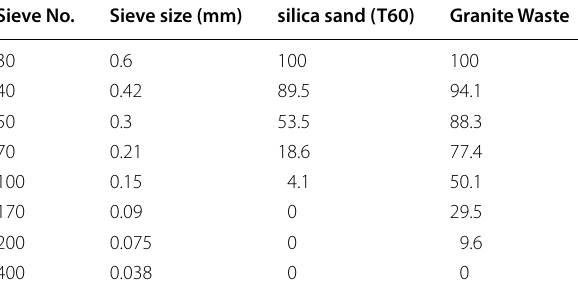
Table 2 Grading of the aggregates Sieve No.